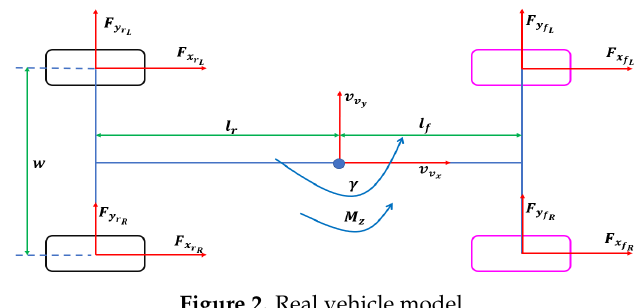
Figure 2. Real vehicle